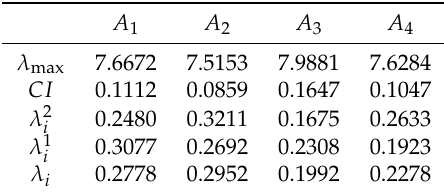
Table 3. Calculation parameter.